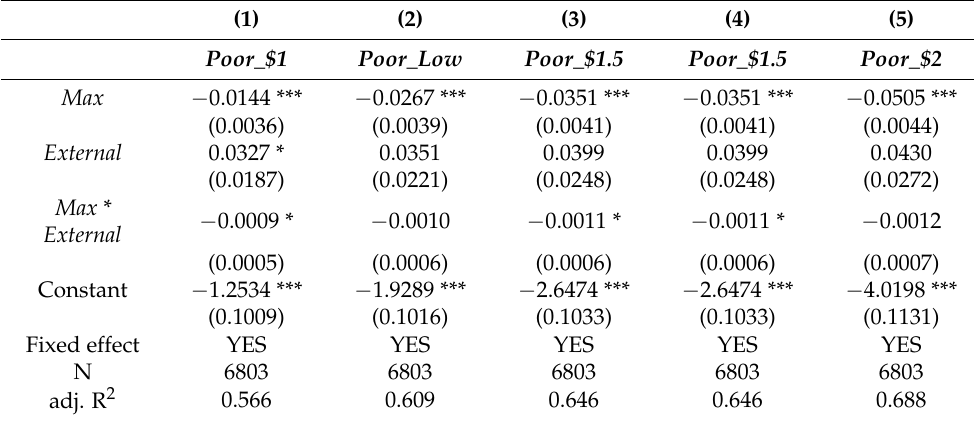
Table 14. Impact of extreme heat on poverty vulnerability—migrant